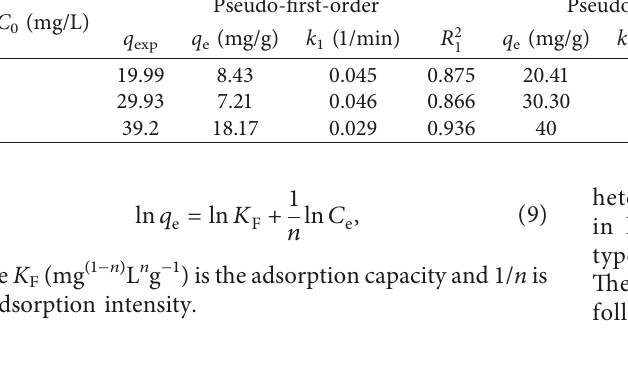
Figure 7: Pseudo-first-order (a), Pseudo-second-order (b), and Intraparticle diffusion (c) plots for adsorption of MB by geopolymer. Table 5: Kinetic parameters for the adsorption of MB on geopolymer. Dye C 0